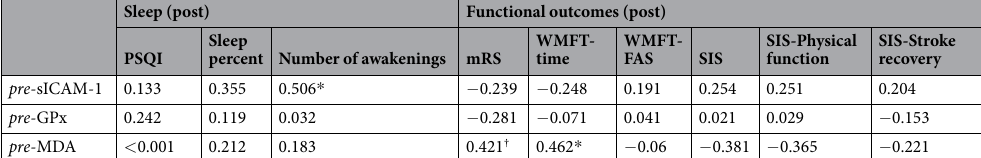
Table 2. Spearman correlation coefficient ( ρ ) between baseline biomarkers and post-treatment sleep and functional outcomes (N = 20). sICAM-1 = Soluble intercellular adhesion molecule-1; GPx =